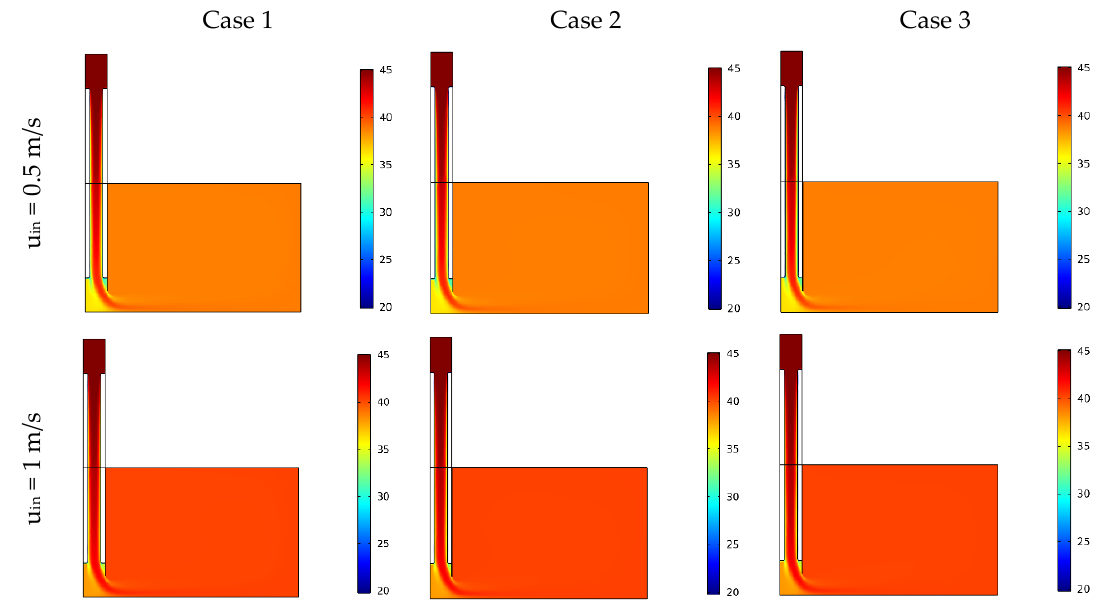
◦ C, and t = 1000 s. in = 45